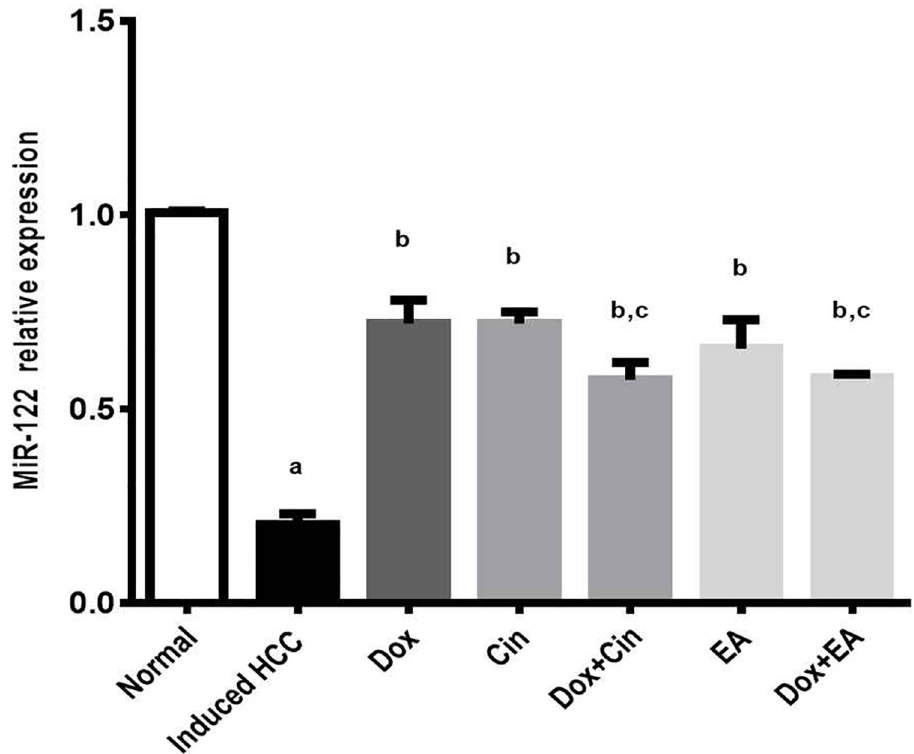
Fig 2. MiR-122 expression using the qRT-PCR technique of DEN/2-AAF-induced HCC rats. Rats were treated with 1,8 cineole (Cin), ellagic acid (EA), doxorubicin (DOX), and combinations. Data are presented as mean ± S.E.M, n = 10. ‘ a ’ P < 0.05 vs. normal group, ‘ b ’ P < 0.05 vs. DEN/2-AAF-induced HCC group and ‘ c ’ P < 0.05 vs. DOX treated group using one-way ANOVA followed by Tukey’s post-hoc test.